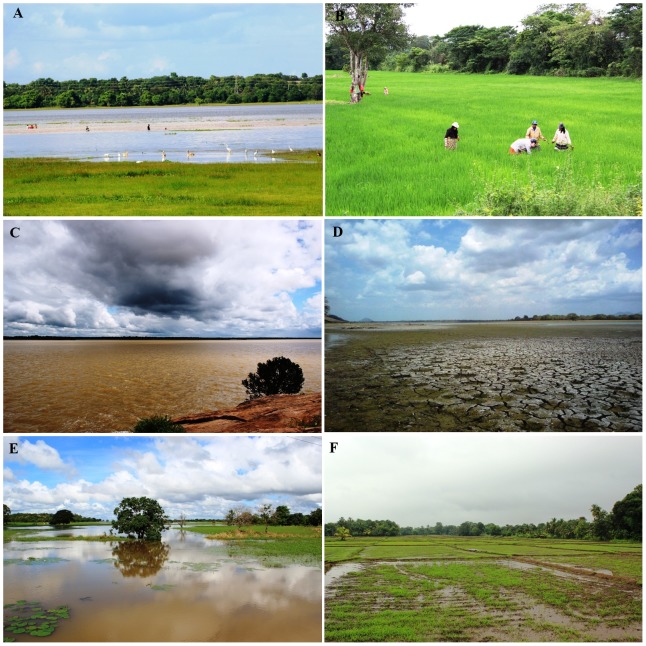
Geography of Anuradhapura showing paddy fields and water reservoirs.(A)Partially dried water reservoir (Nuwara Wewa) during dry season (B) Females removing weeds in paddy fields (C) Water reservoir during the rainy season (D) Dried up reservoirs during dry season (E) Flooding in Anuradhapura (F) Paddy field during the cultivation season.